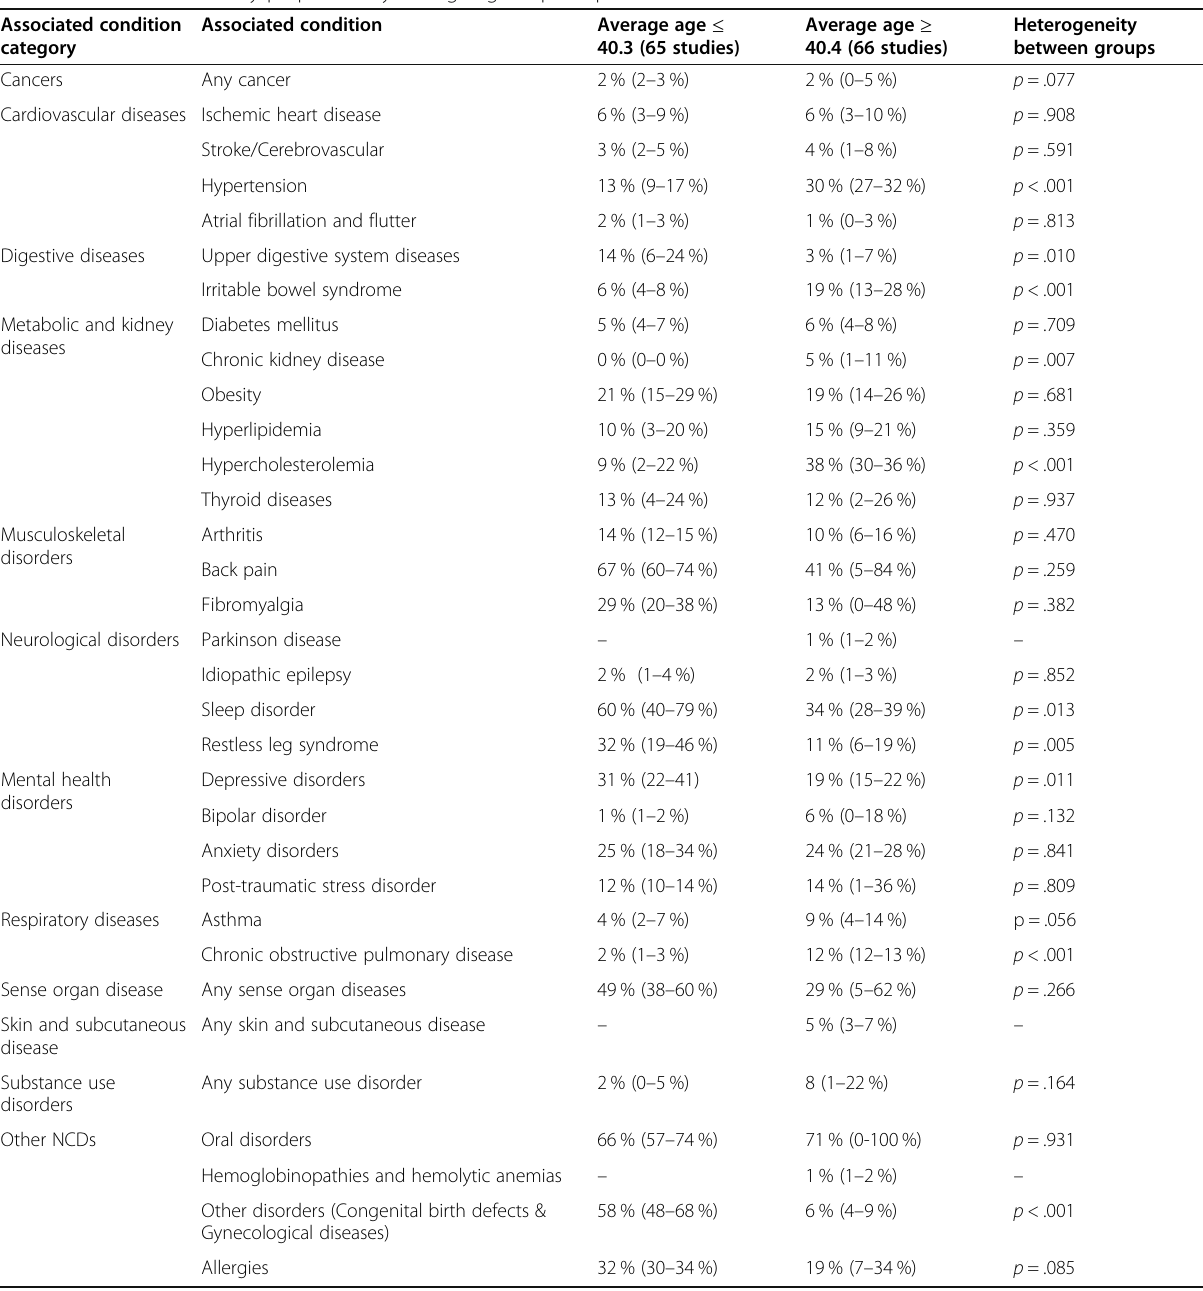
Table 5 Pooled comorbidity proportion by average age of participants Associated condition